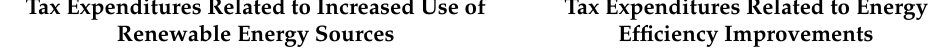
Table 2. Tax expenditures aimed at achieving environmental sustainability in selected OECD